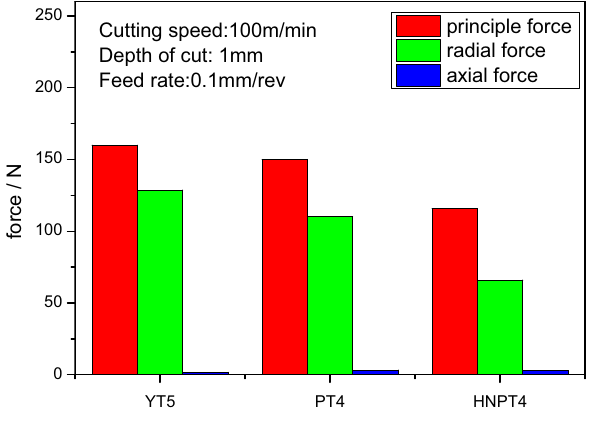
Figure 4: Cutting force of di ff erent tools.